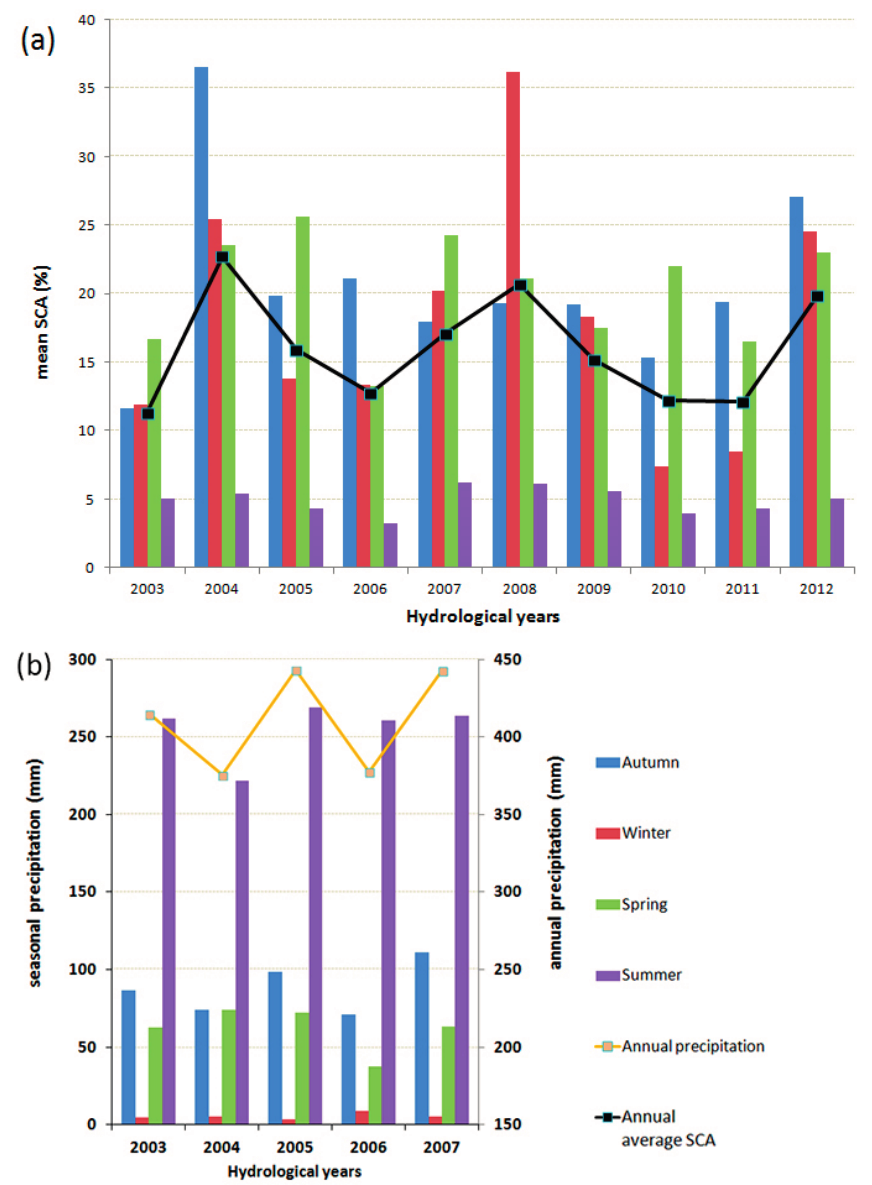
Figure 4. Mean seasonal SCA in HY2003–HY2013 ( a ) and cumulative precipitation in HY2003–HY2007 ( b ) in the upper Heihe River